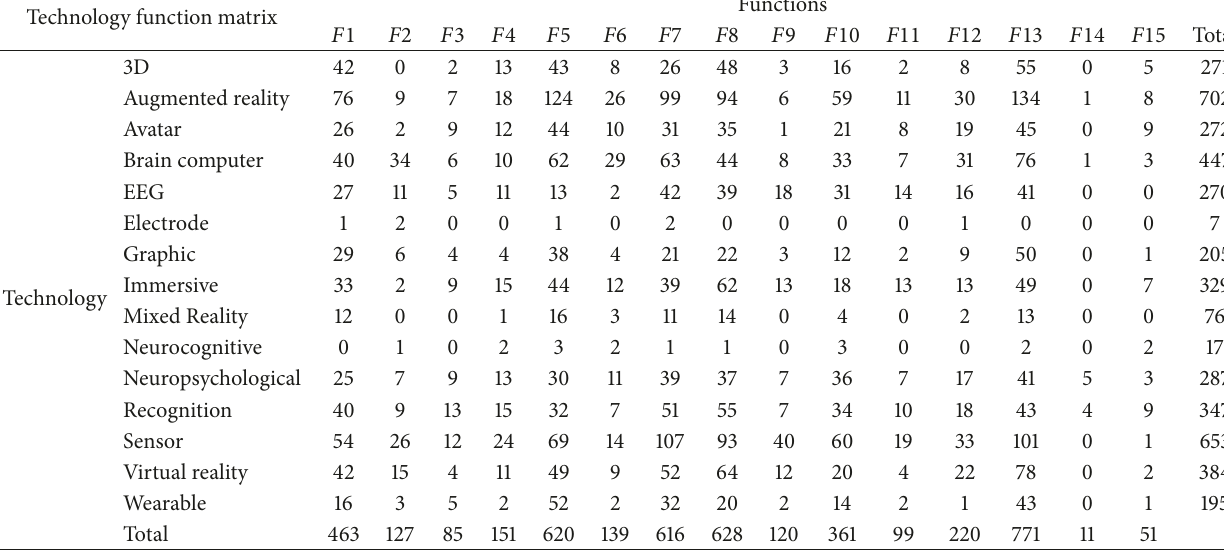
Table 7: IIT technology function